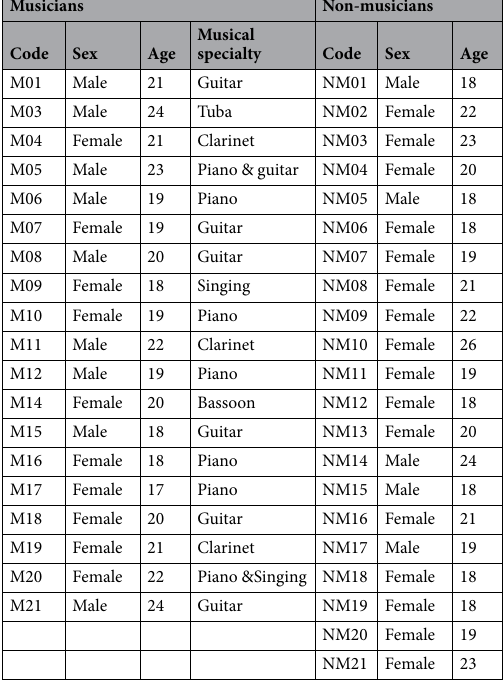
Table 6. Demographic data & musical specialty of the